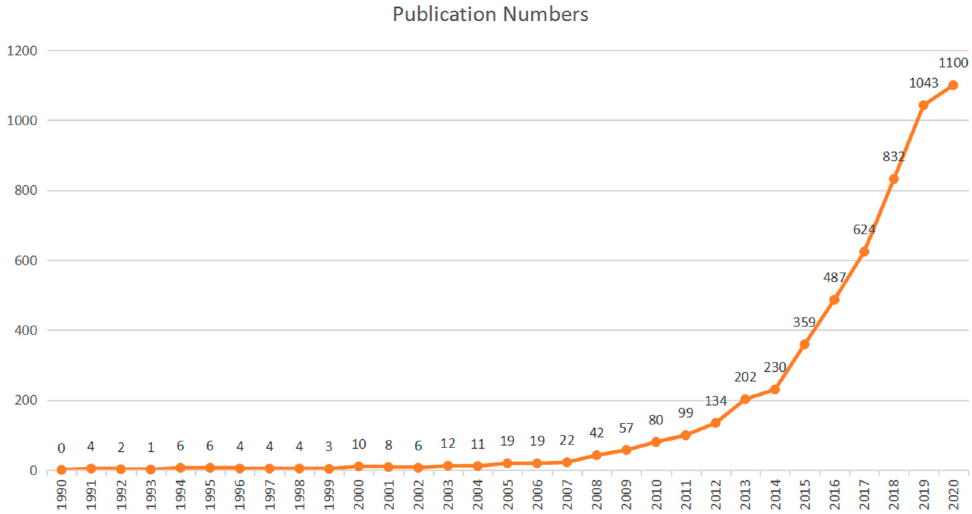
Figure 1. A descriptive, quantitative analysis of the database in Citespace.